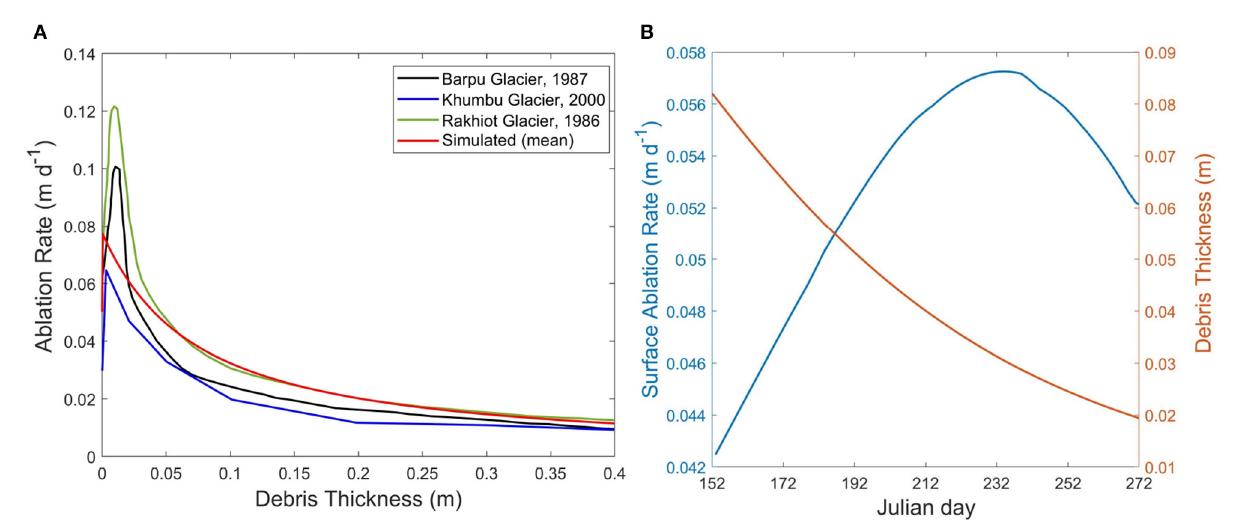
FIGURE 6 | The debris-thickness control on surface ablation rates. (A) June-averaged ablation rate as a function of debris thickness on the Baltoro Glacier (red) compared to in-situ measurements in the ablation season on other Himalayan glaciers (replotted), including Barpu Glacier ( Khan, 1989), Khumbu Glacier (Kayastha et al., 2000 ), and Rakhiot Glacier (Mattson, 1993). Note that the melt-enhancing effect of thin-debris is observed on all glaciers. (B) An example of the temporal variation in ablation rate vs. debris thickness around a supraglacial lake on the Baltoro Glacier. The debris layer is getting thinner as sediments are gradually sliding into the lake, which leads to an increase in ablation rate (the decrease of ablation rate in late ablation season is due to the decreasing